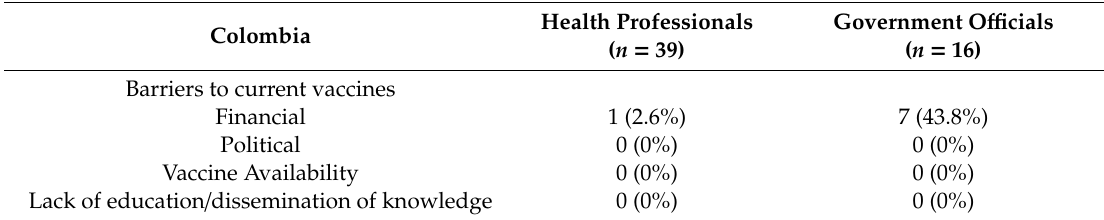
Table 3. Self-reported barriers to currently providing mandated vaccines and to implementing the dengue vaccine in Colombia. Free responses were then coded into the categories